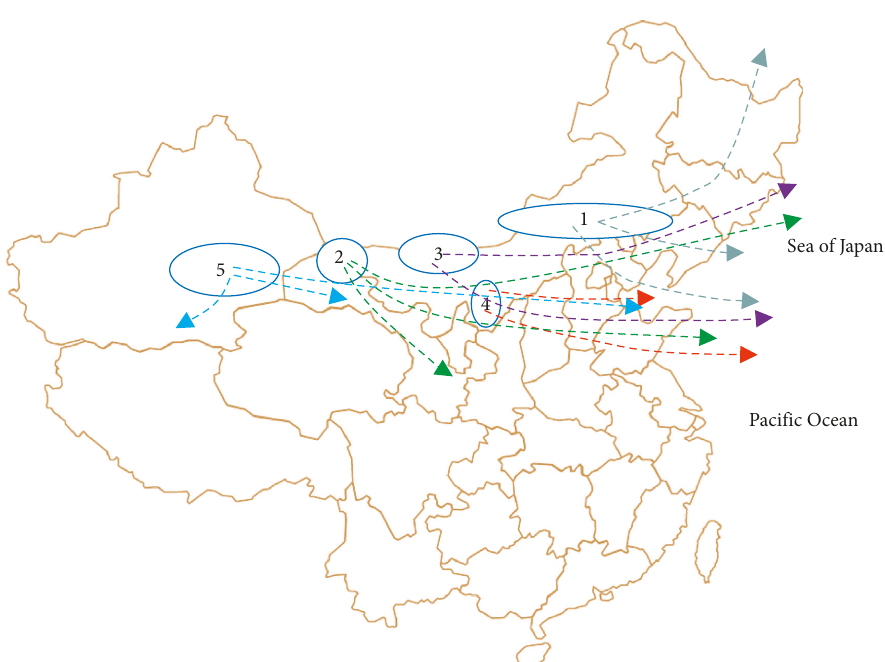
Figure 4: Dust sources and transport pathways identified by MODIS [15]. Note:1 represents sandy lands in central Inner Mongolia and the adjacent area of Mongolia; 2 represents the Gobi Desert in western Inner Mongolia and neighboring areas in Xin Jiang, Gan Su, and southwestern Mongolia; 3 represents the Gobi Desert and sandy deserts of western Inner Mongolia and adjacent areas of southwestern Mongolia; 4 represents sandy lands and deserts along the middle reaches of the Yellow River; 5 represents the rim of the Taklamakan Desert. Colored arrows show the paths of dust transport between Mongolia and northern China, derived from time-series satellite images and the NOAA HYSPLIT model